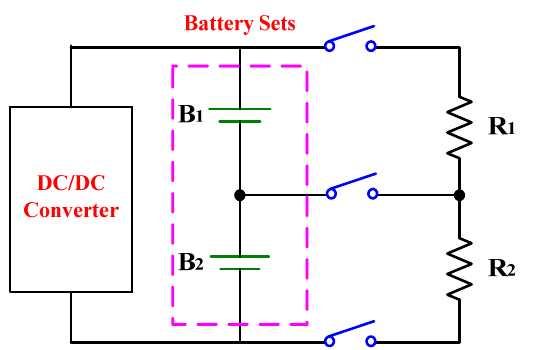
Figure 1. Equalization circuit of dissipative